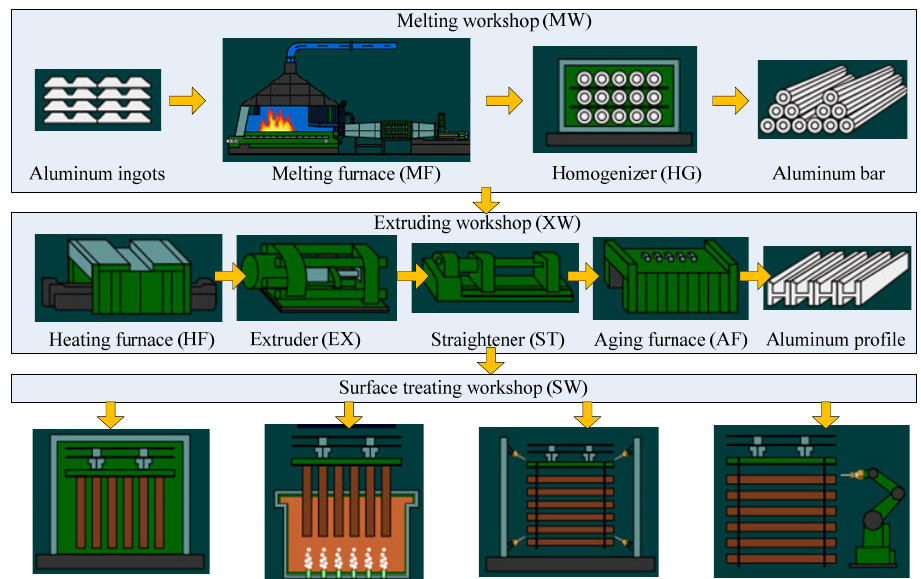
Figure 5. Process model of the studied aluminum profile plant.